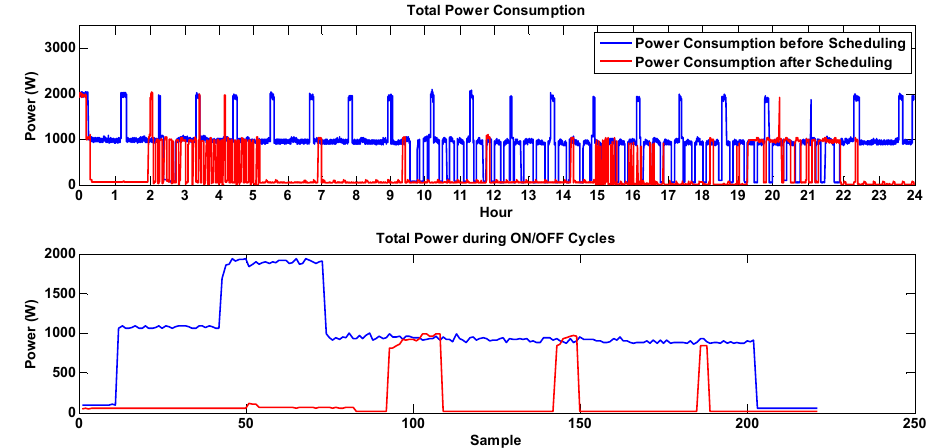
Figure 25. Total power consumptions of all the appliances without and with the use of the HEM system.